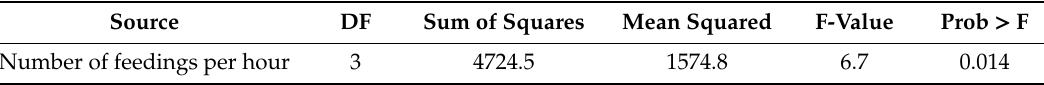
Table 4. One-way ANOVA for number of feedings per hour on screen size. n = 12. Source DF Sum of Squares Mean Squared F-Value Prob > F Number of feedings per